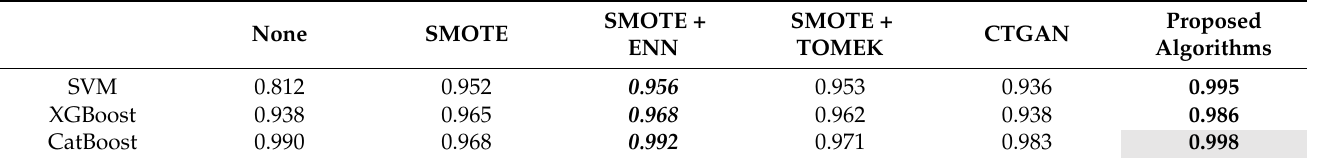
Table 5. AUC score of the classification algorithm according to each data